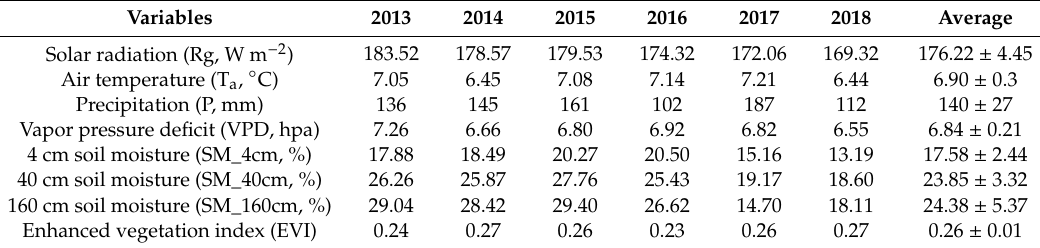
Figure 3. Temporal variations in daily mean solar radiation (Rg, W m − 2 ) ( a ), air temperature (Ta, ◦ C) ( b ), vapor pressure deficit (VPD, hpa) ( c ), daily integrated precipitation (P, mm) ( d ), enhanced vegetation index (EVI) ( e ), and relative extractable water (REW) ( f ) at di ff erent depths. Table 1. Statistics of annual climatic variables in Daman site during